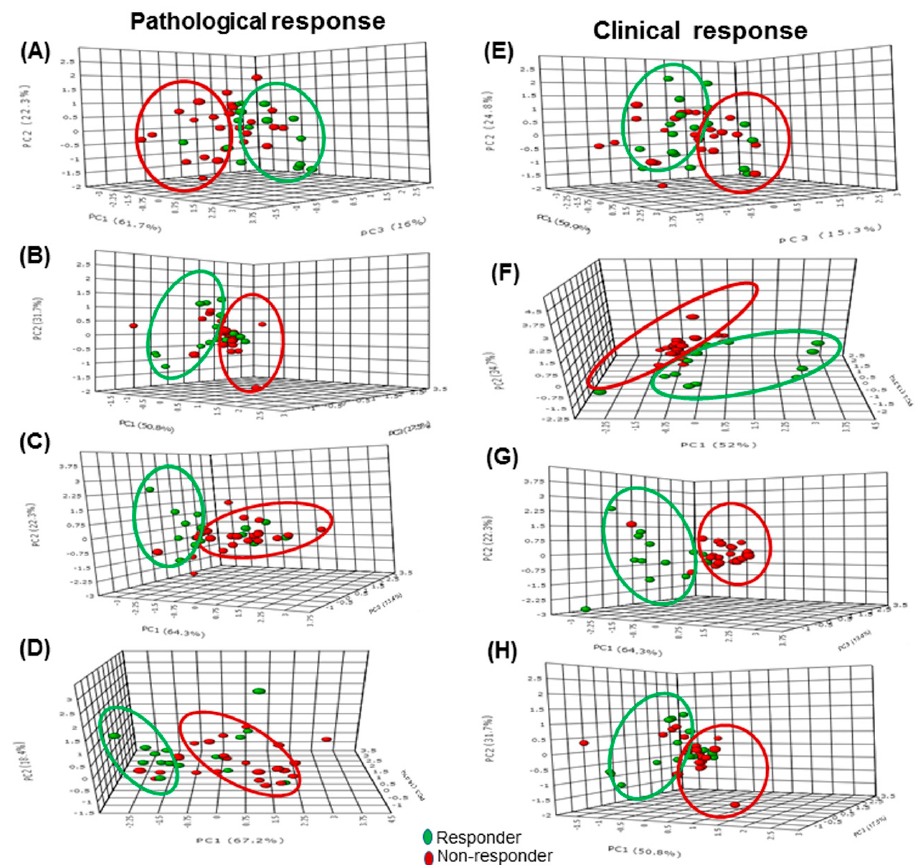
Figure 7. The 3-D score plot (PC1-PC3) of PCA analysis of multi-parametric data (volume, ADC, and tCho) in pathological responders and nonresponders at Tp0 ( A ) after Tp1 ( B ), Tp2 ( C ), and Tp3 ( D ), while ( E – H ) show the 3-D score plot for clinical response. (Reproduced with permission from Reference [110]: Sharma, U.; Agarwal, K.; Sah, R.G.; Parshad, R.; Seenu, V.; Mathur, S.; Gupta, S.D.; Jagannathan, N.R. Can a multi-parametric MR based approach improve the predictive value of pathological and clinical therapeutic response in breast cancer patients? Front. Oncol . 2018, 8 , 319. doi: 10.3389/fonc.2018.00319). Advanced approaches such as intravoxel incoherent motion (IVIM) modeling are used to characterize breast malignancy [147–149]. Besides diffusion, these methods also provide information on tissue perfusion [147–149]. Additionally, diffusion kurtosis mod- eling [148,150] and diffusion tensor imaging (DTI) [151,152] are also being investigated to characterize the directionality of water diffusion and understand tissue complexity. 3.9. Breast Biomarkers: MR Elastography (MRE) In breast cancer, the reactive proliferation of connective tissue leads to the accumu- lation of a dense layer of fibroblasts around malignant epithelial cells [153]. It results in hardening or change in the stiffness of the breast tissue, which is diagnosed by palpation. MRE is a noninvasive imaging technique to measure the stiffness or elasticity of tissues and uses low-frequency vibrations to quantitatively measure the visco-elastic properties of tissue during malignant transformation [15–17,154]. The stiffness of tumors is related to tumor development, metastasis, invasion, and resistance to chemoradiotherapy [154].